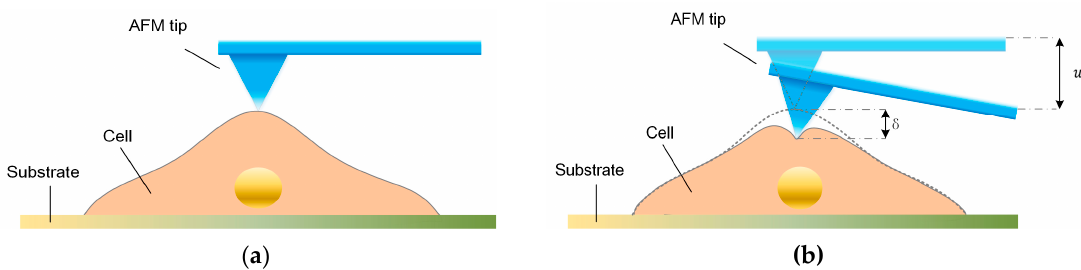
Figure 1. Illustration of the atomic force microscope (AFM) indentation experiment and the experimental curve from one entire indentation process. ( a , b ) Schematic diagram of indentation applied using an AFM probe tip on a single cell.